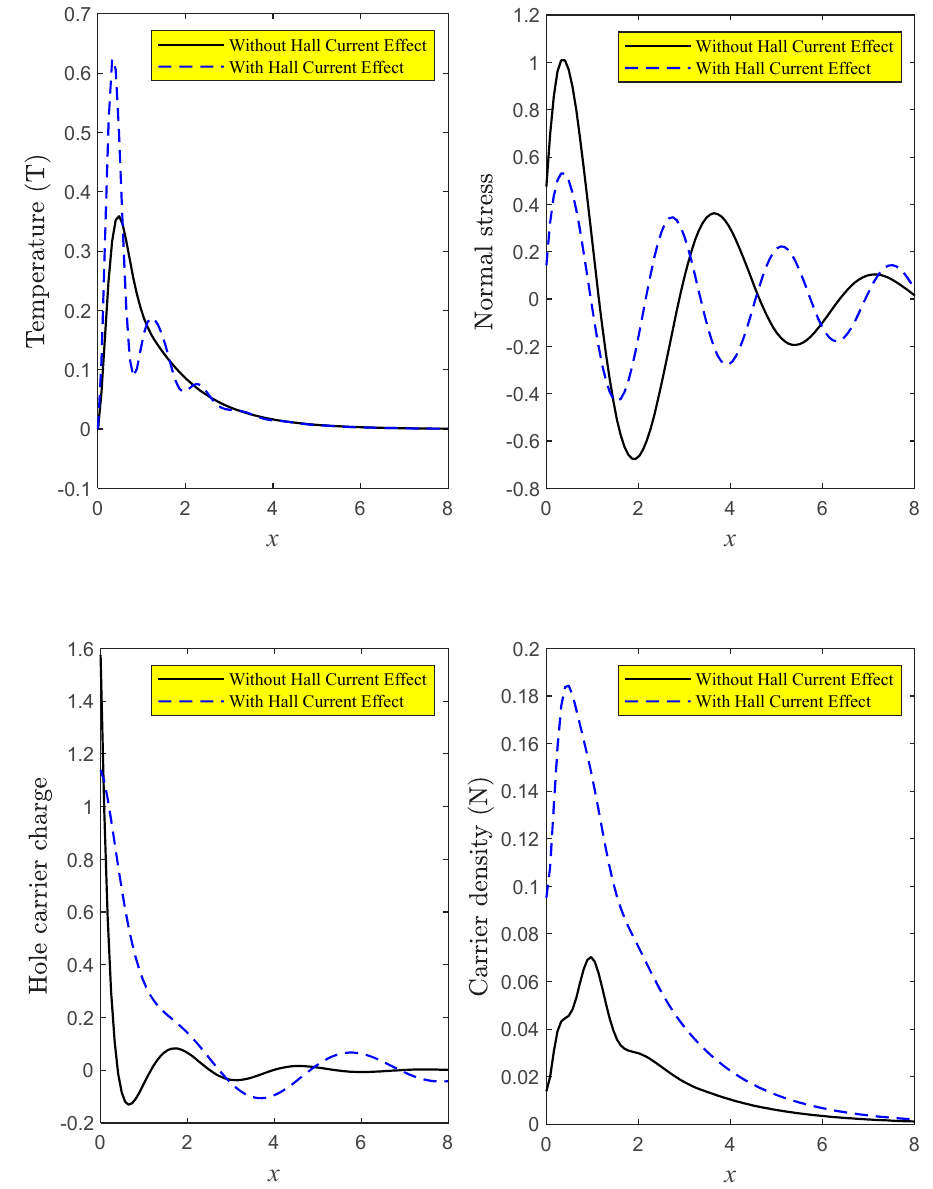
Figure 2. In both the presence and absence of the Hall current effect, the main field distributions against distance vary, according to the DPL model in non-local case.